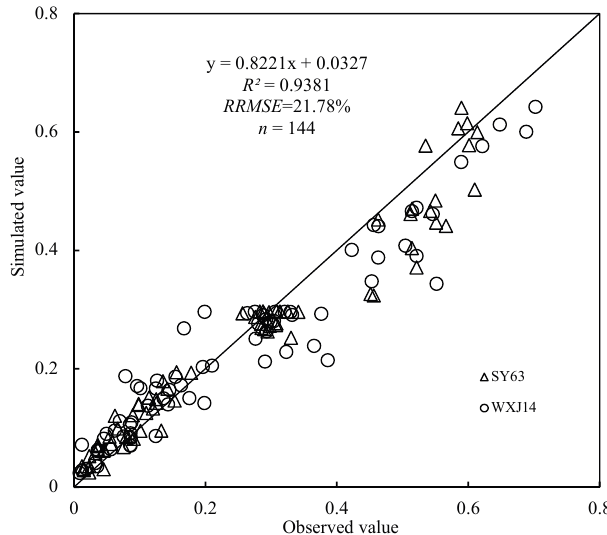
Figure 9. Comparison of simulated and measured leaf inclination angle distribution in the rice